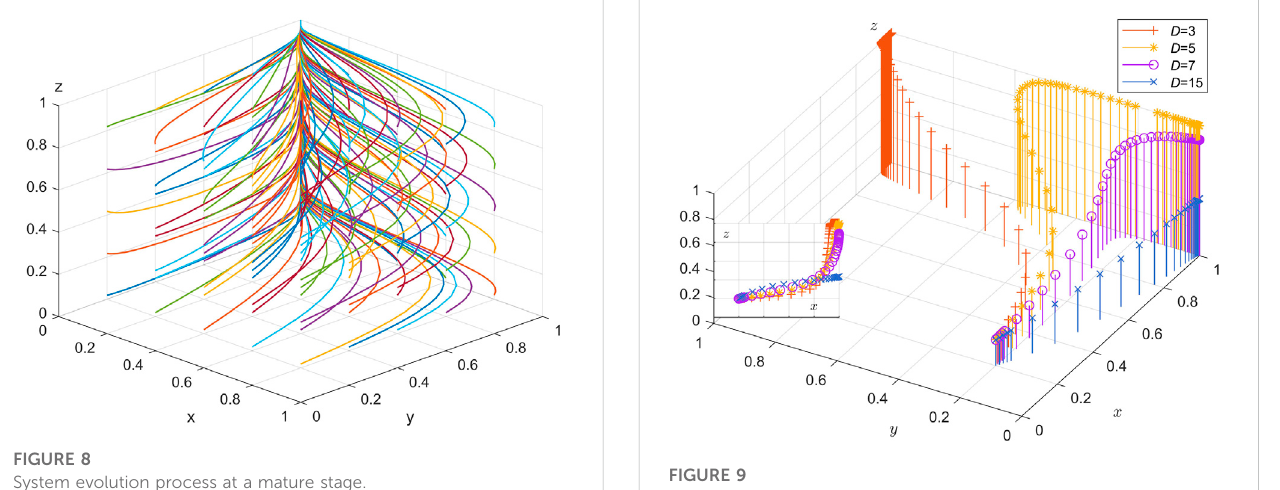
Figure 7. After similar simulations, it can be observed that after several iterations, the lines converge to the equilibrium point of E8 (1,1,1), which also determines the ESS of the rapid development phase.